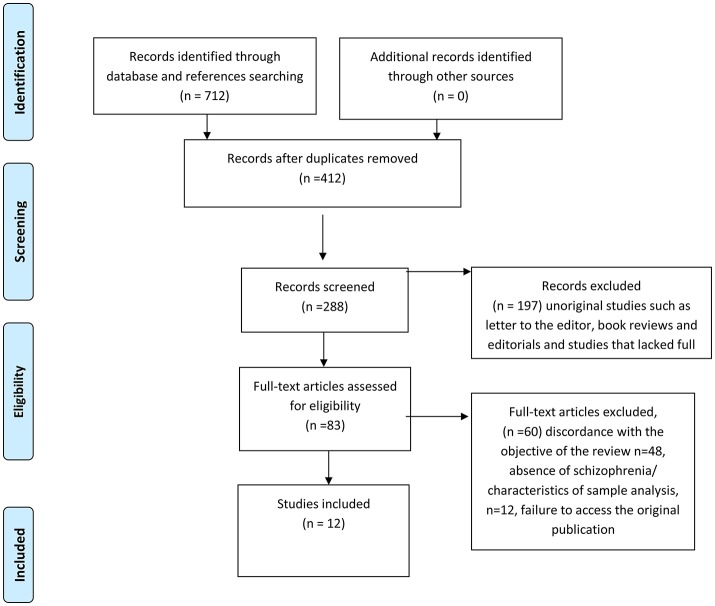
Prisma Flow Diagram.